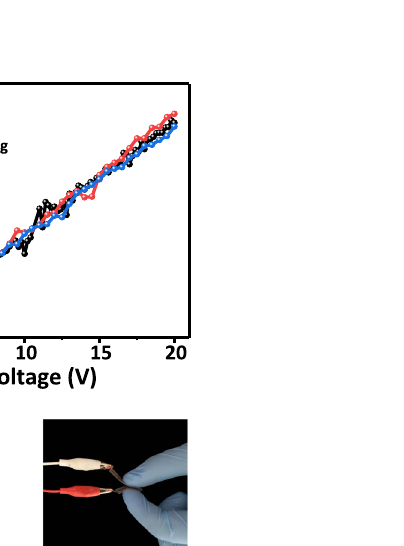
Fig.4|TheproposeddelaminationmechanismoftheCu-Trzcrystalduringthe plasticbending. The schematicdiagramsand crystal structures before ( a ),during ( b ), and after bending ( c ). Note that the red, yellow and green lines represent the